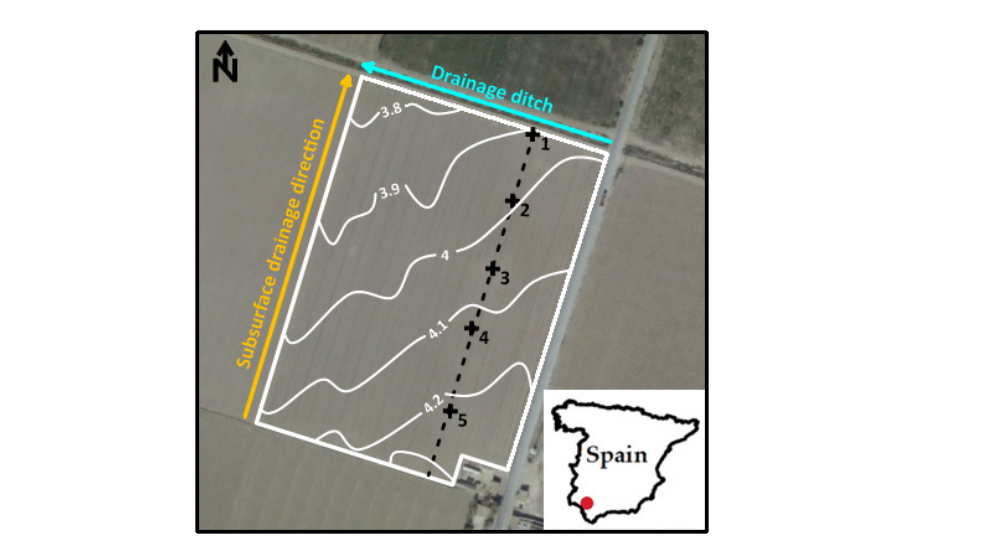
Figure 1. Image of the study field with topography and location of the five sampling points along the transect (Google Earth, 2022) [24].